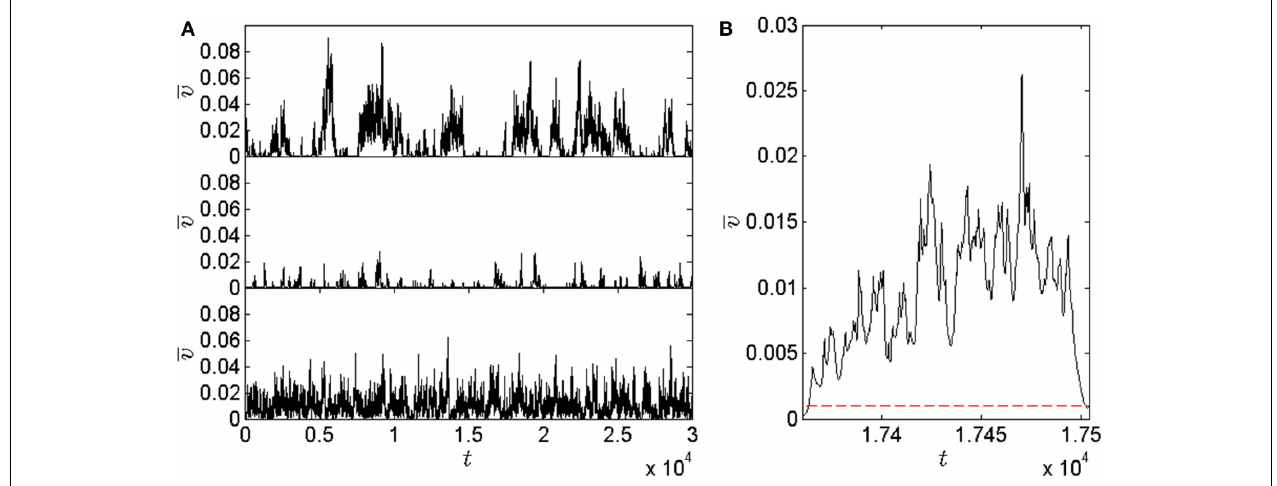
FIGURE 2 | (A) Evolutions of the continuum-level scale velocity v ( t ) for three typical parameter sets within the crackling phase: { c = 10 − 5 , k = 10 − 3 , ˜ η = 1, N = 1024 } (top), { c = 10 − 5 , k = 10 − 2 , ˜ η = 1, N = 1024 } (middle), { c = 10 − 4 , k = 10 − 2 , ˜ η = 1, N = 1024 } (bottom). (B) Zoom in on